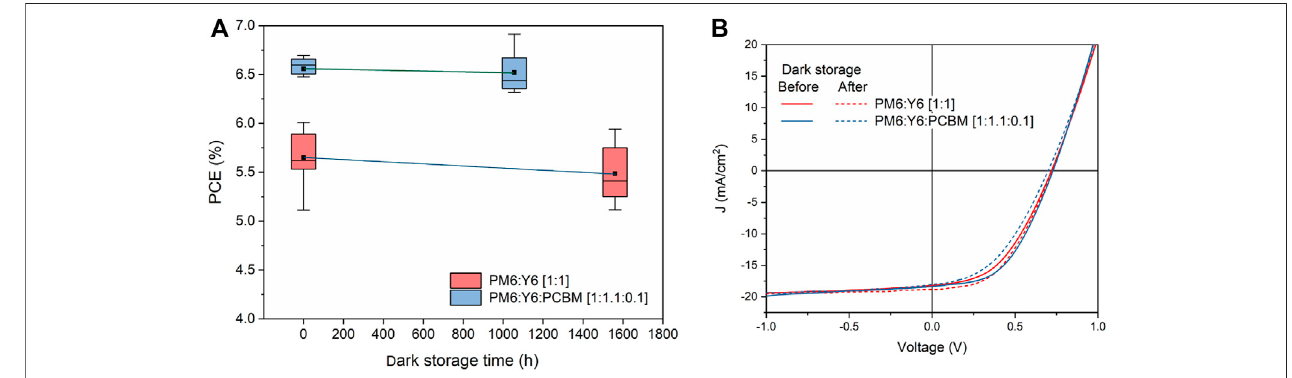
FIGURE 8 | (A) Stability of PM6:Y6 devices under dark storage and (B) J-V curves of corresponding devices before and after